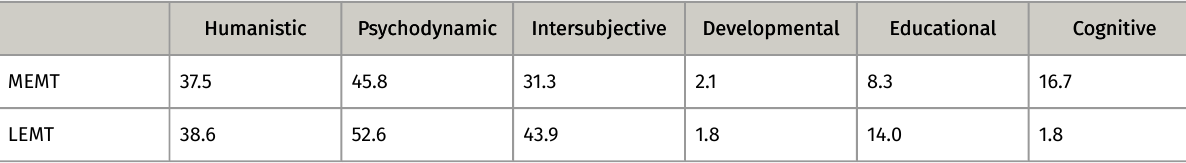
TTablablee 44 Psychological Theoretical Framework of MEMTs and LEMTs (in percentages out of the total number of participants in each